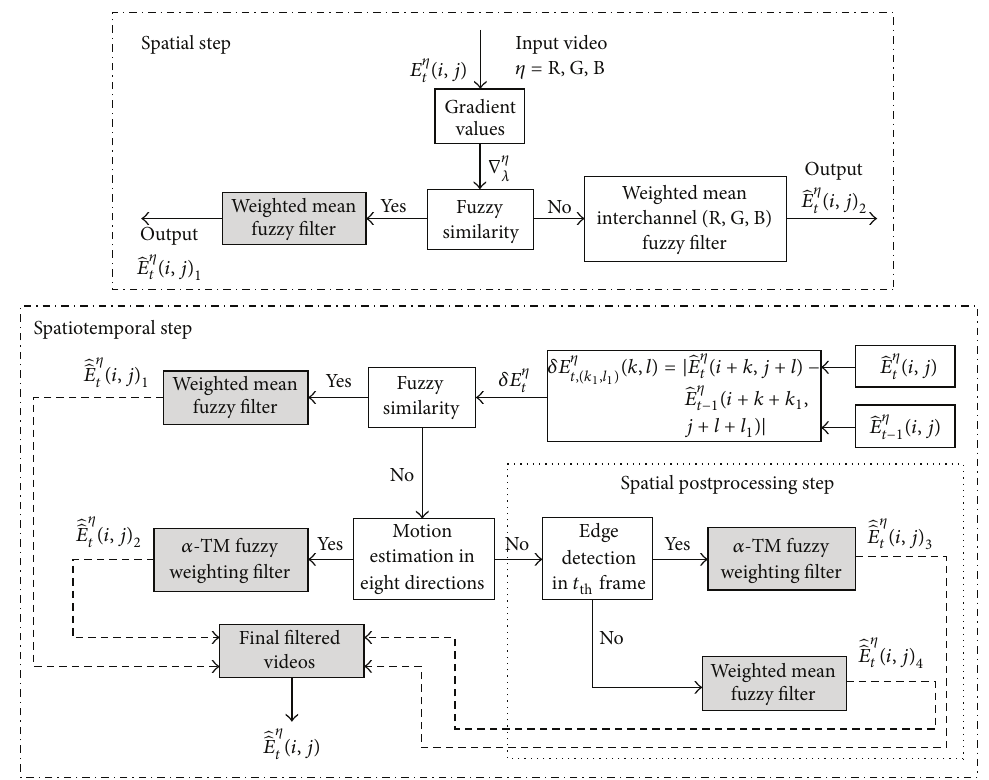
Figure 1: The general denoising scheme of the proposed filtering technique.